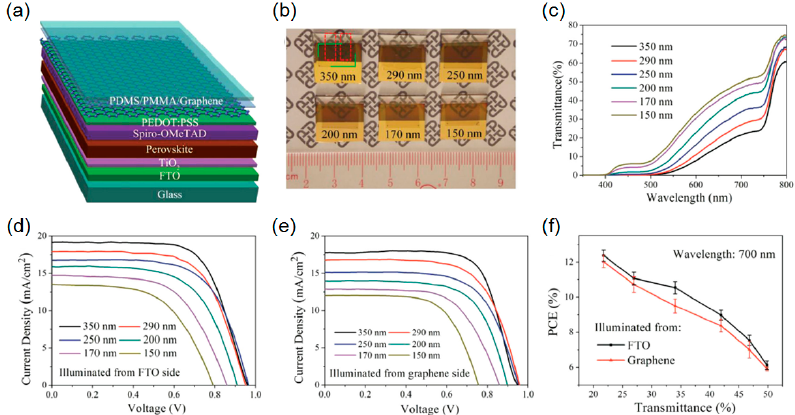
Figure 5. ( a ) Schematic view of a semitransparent perovskite solar cell employing a graphene based transparent top electrode. ( b ) Photos of semitransparent perovskite solar cells with transparent graphene electrodes. The thicknesses of the perovskite layers in the six devices are approximately 350, 290, 200, 170, and 150 nm, respectively. ( c ) Transmittance spectra of the above devices. J - V characteristics of the semitransparent solar cells illuminated from ( d ) the FTO side and ( e ) the graphene side. ( f ) The average PCEs of the semitransparent perovskite solar cells as a function of the transmittance at the wavelength of 700 nm. Reproduced with permission [35].